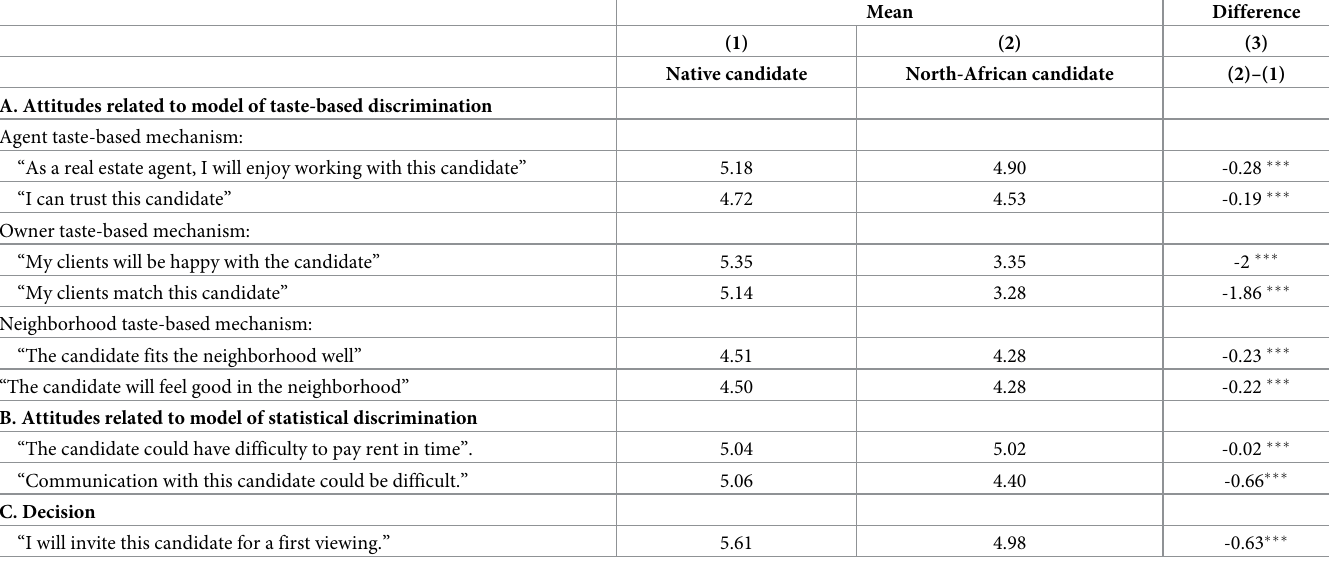
Table 2. Mean rental candidates’ scores with respect to different mechanisms of discrimination and the final decision on a 7-point rating scale (n =